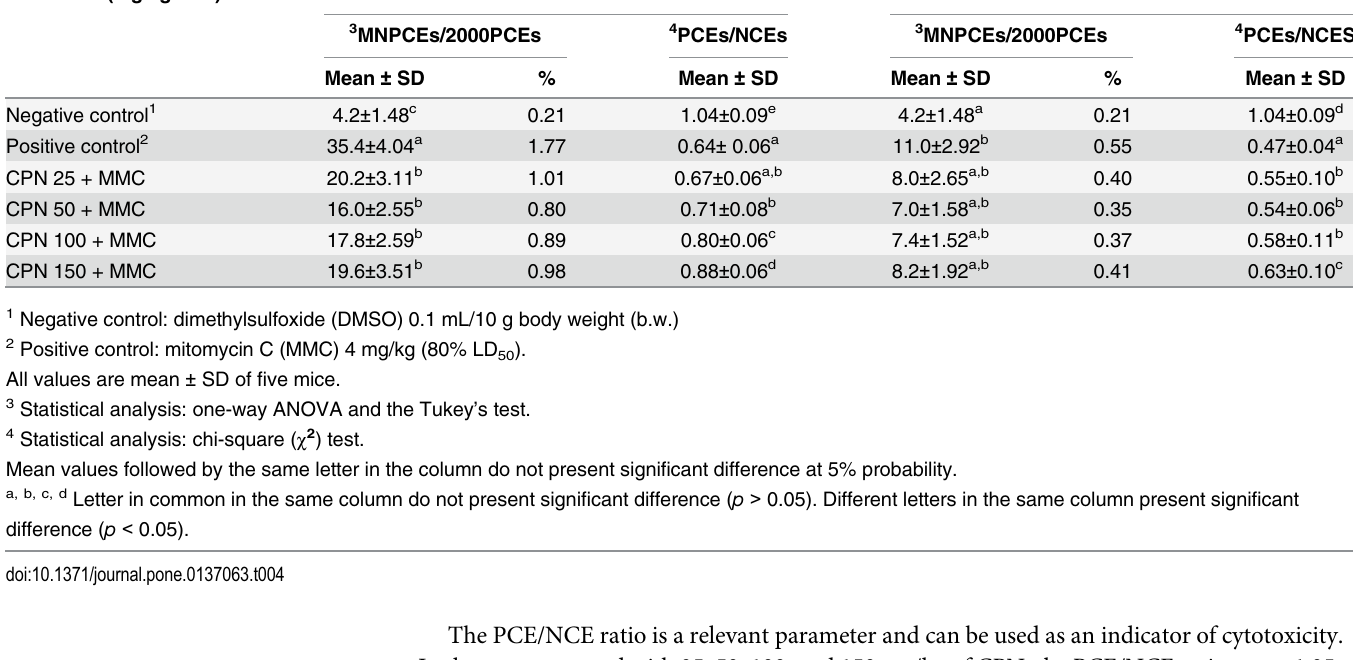
Table 4. Evaluation of anticytotoxic and antigenotoxic activities in the bone marrow of mice treated with sulfonamide chalcone N-{4-[3-(4-nitrophe- nyl)prop-2-enoyl]phenyl}-benzenesulfonamide (CPN) plus mitomycin C (MMC) based on MNPCE and PCE/NCE frequency. Treatment (mg/kg